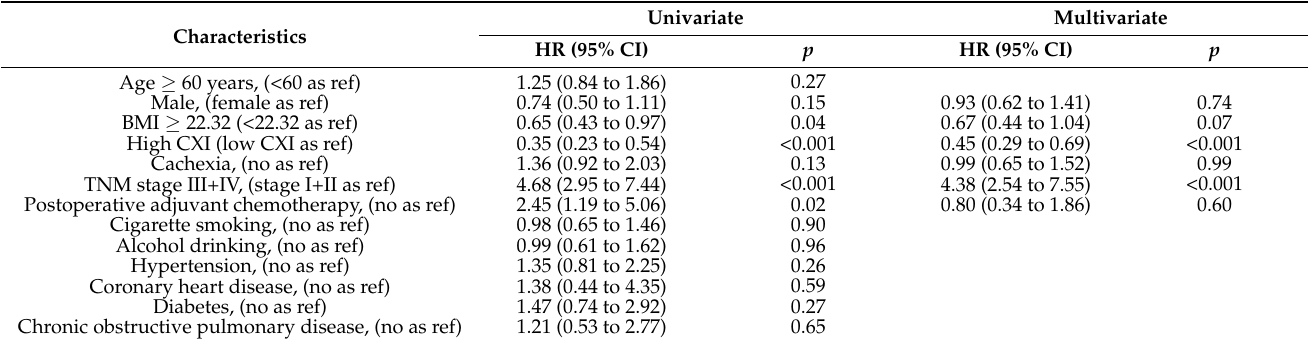
Table 2. The Cox univariate and multivariate analysis of overall survival.